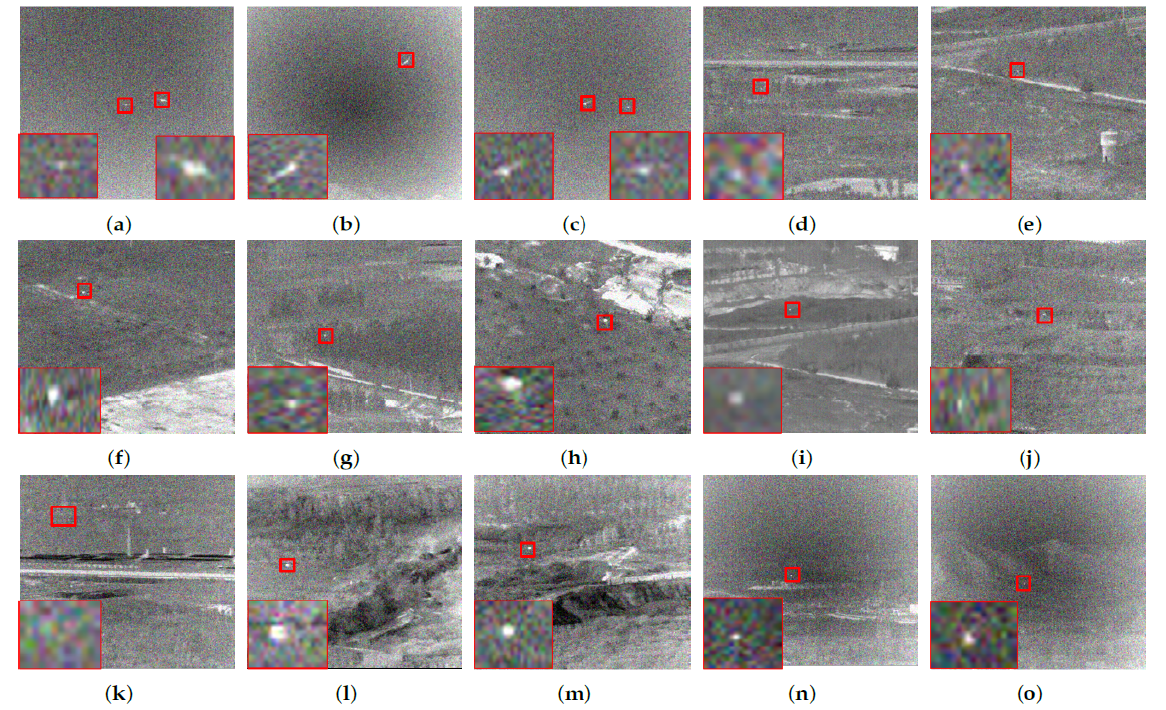
Figure 20. The original images’ added noise with mean 0 and variance 0.01. ( a – o ) represent the corresponding scenes in Figure 10.